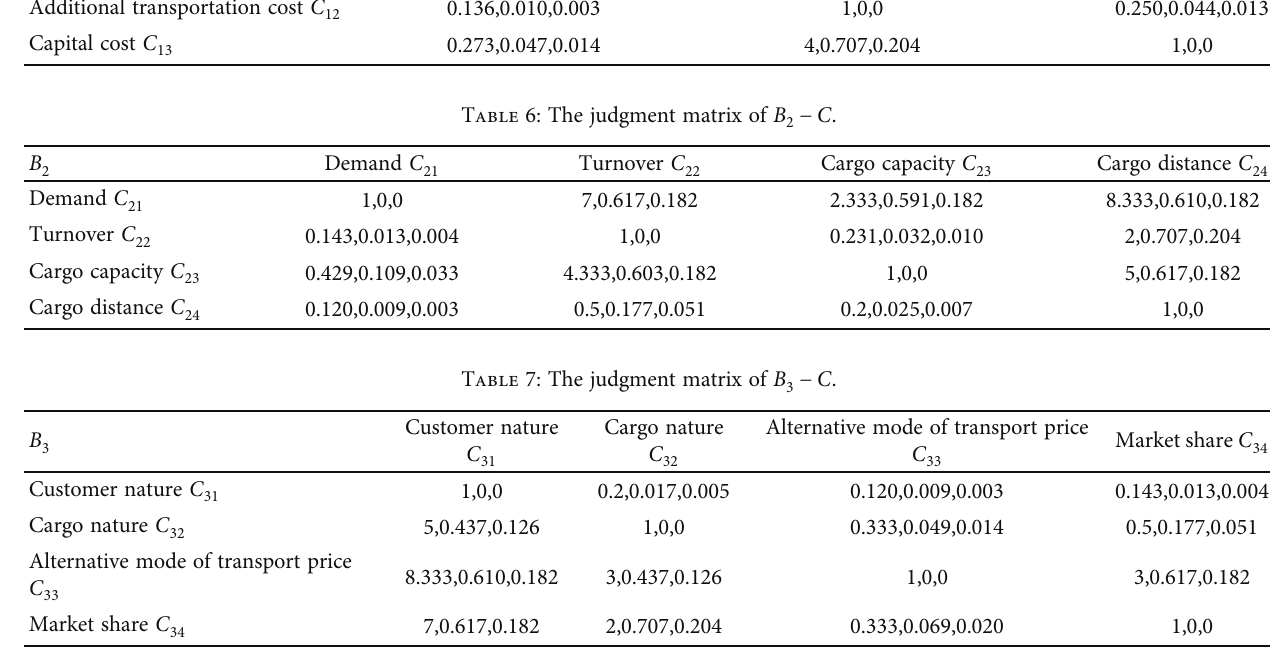
Table 5: The judgment matrix of B